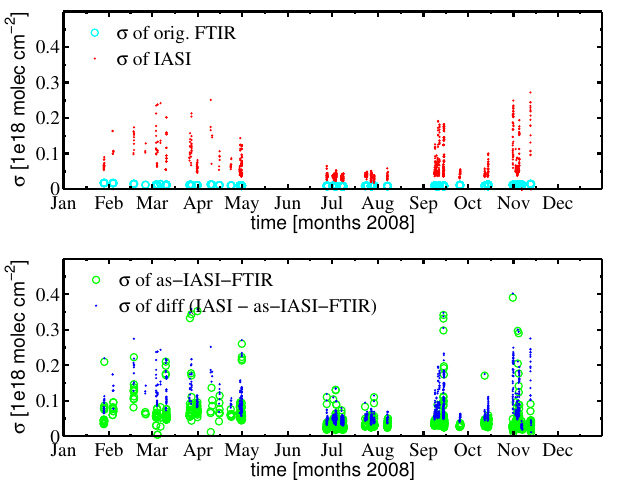
Fig. 7. Carbon monoxide random error of the differences against differences of the IASI-FTIR total column for the quality-filtered data for Kiruna. For the values indicated in blue (red), the absolute values of the differences are smaller (larger) than the random errors (VCD = vertical column